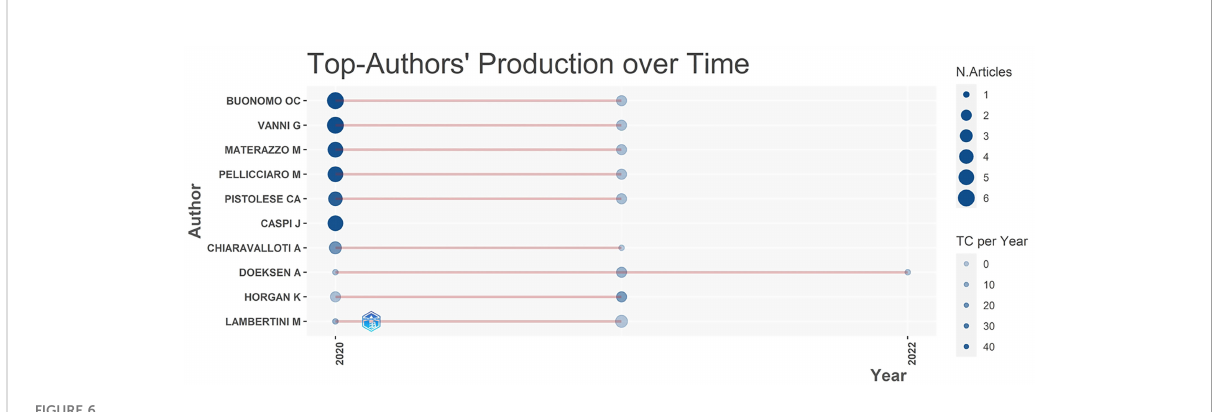
FIGURE 6 The top author ’ s production over